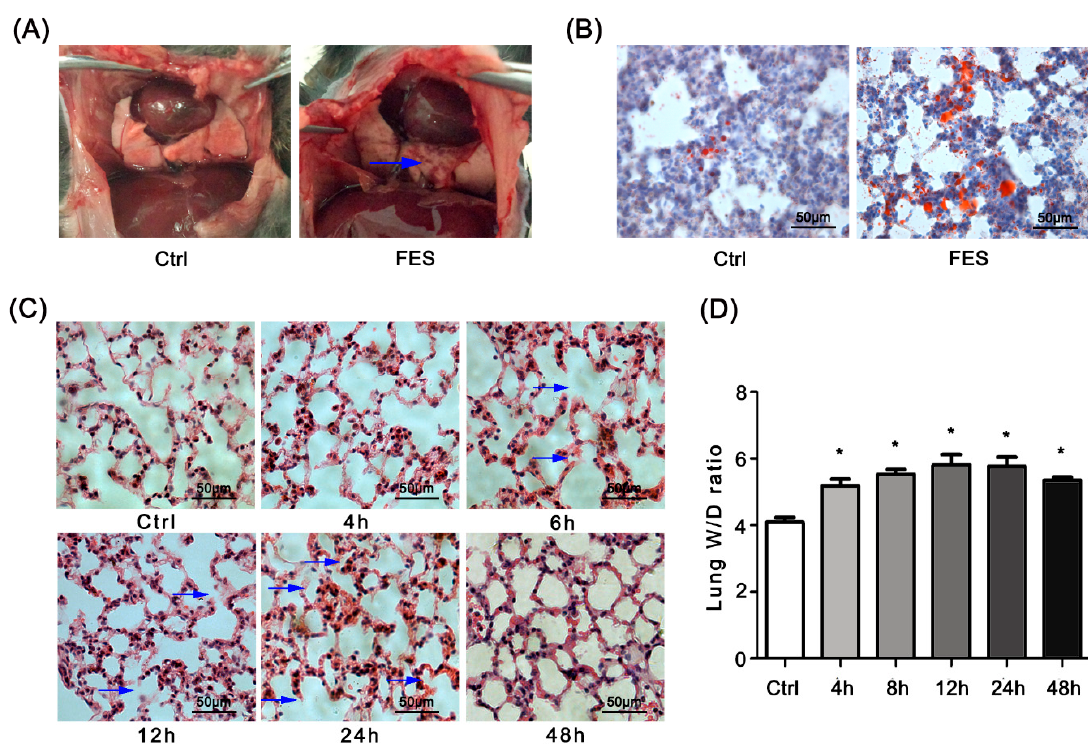
Figure 1. Pulmonary edema occurs in FES mice. ( A ) Gross morphology of the lungs in the control and FES (fat embolism syndrome) groups. Blue arrow, infarction tissues; ( B ) Lung sections from the control and FES groups were stained with Oil Red O; ( C ) Lung sections from the FES group at different time points after fat injection were stained with H & E. Blue arrow, ruptured alveolar wall; ( D ) W / D ratio in the FES group at different time points after fat injection. * p < 0.05, the statistics were made by comparing with Ctrl group, respectively.